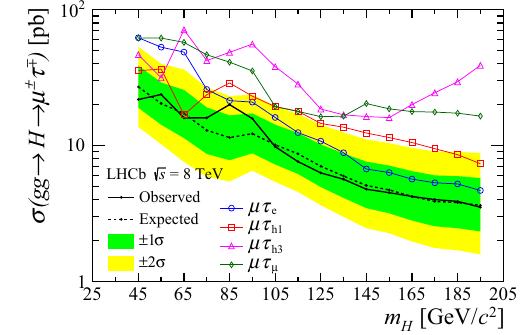
Fig. 2 Cross-section times branching fraction 95% CL limits for the H → μ ± τ ∓ decay as a function of m H , from the simultaneous fit. The observed limits from individual channels are also shown mass of 45 GeV / c 2 , to 4 pb for 195 GeV / c 2 . The search pro- vides information complementary to the ATLAS and CMS